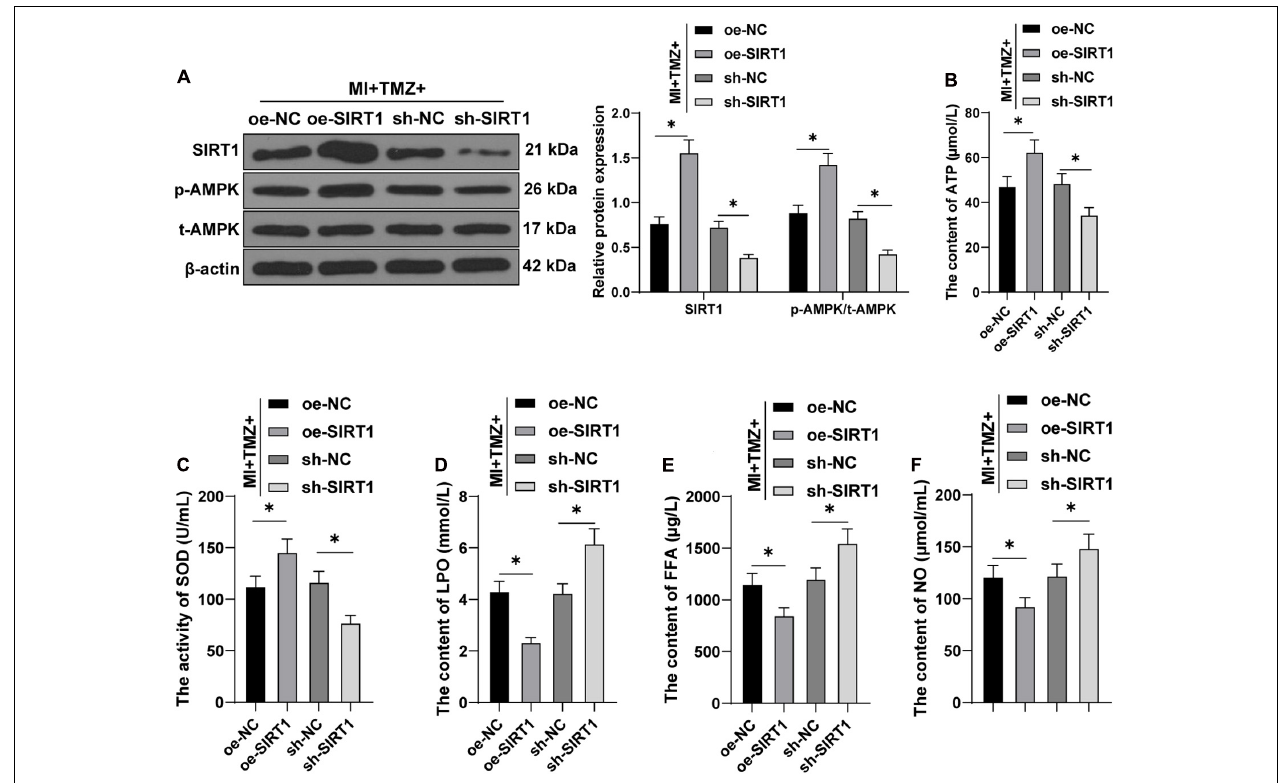
FIGURE 5 | Trimetazidine inhibited MI-induced myocardial energy metabolism via the SIRT1–AMPK pathway in vivo . (A) Western blot analysis of SIRT1, p-AMPK, and t-AMPK. (B) ATP content in H9C2 cardiomyocytes. (C) SOD activity in H9C2 cardiomyocytes. (D–F) Contents of LPO (D) , FFA (E) , and NO (F) in H9C2 cardiomyocytes ( N = 10 per group). All data were expressed as the mean ± standard deviation. Data were analyzed using one-way ANOVA, followed by Tukey’s multiple comparisons test. * P < 0.05. ATP, adenosine triphosphate; SOD, superoxide dismutase; LPO, lipid peroxide; FFA, free fatty acids; NO, nitric